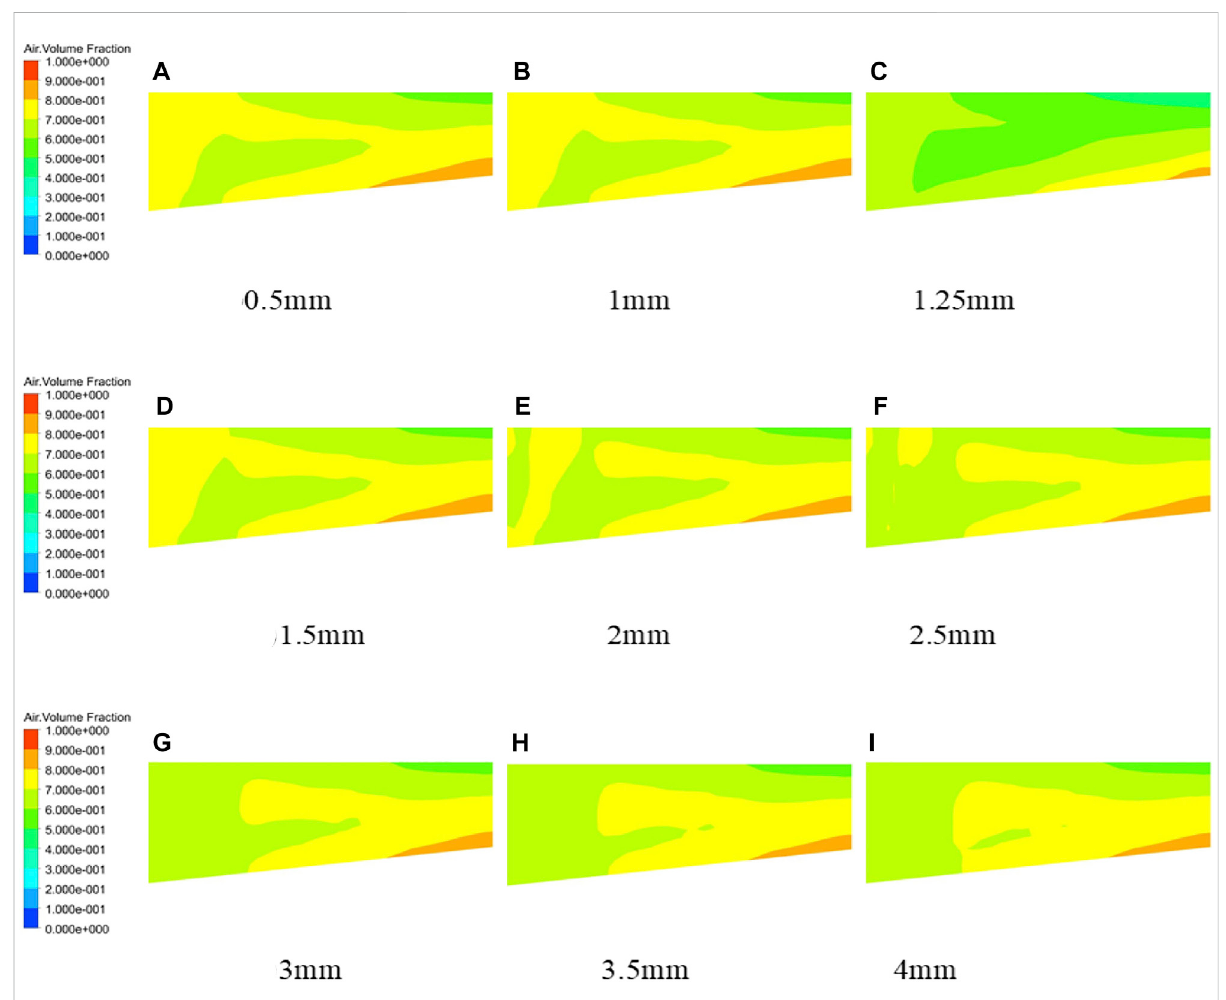
FIGURE 12 Gas-phase distribution diagram of the impeller passage with different maximum thicknesses of composite airfoils. (A) 0.5mm, (B) 1mm, (C) 1.25mm, (D) 1.5mm, (E) 2mm, (F) 2.5mm, (G) 3mm, (H) 3.5mm, (I)